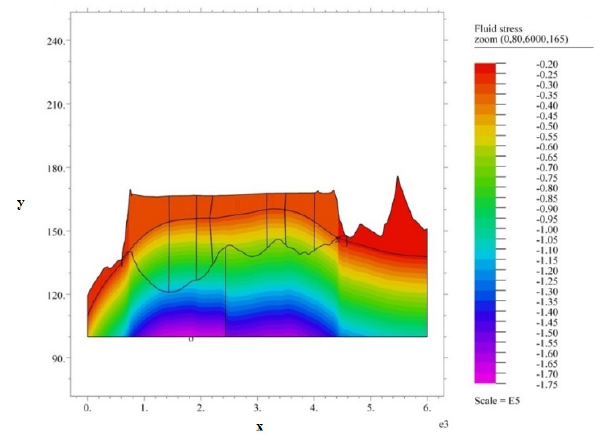
Figure 8: Results for the 2D model – stresses in liquid.